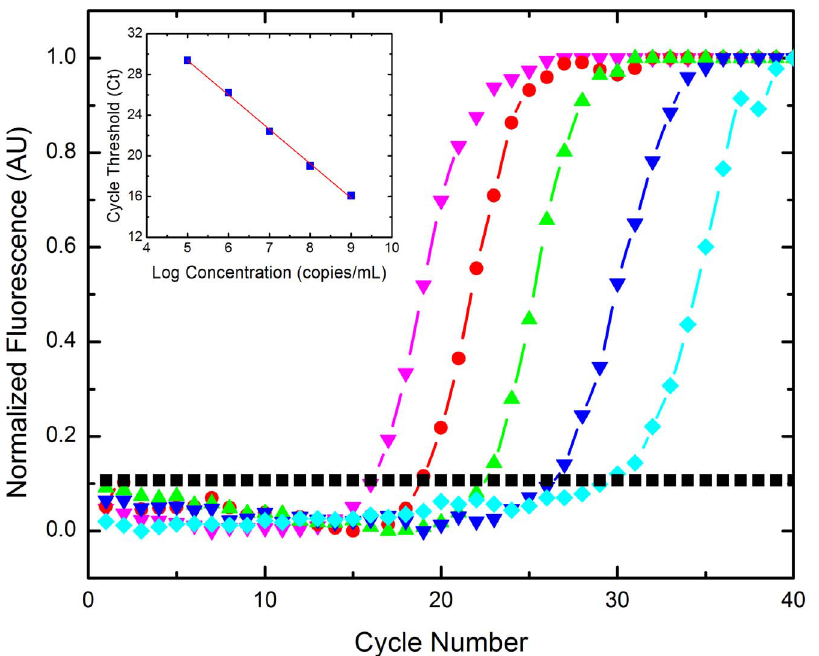
Figure 2. Serial dilution of H3 vRNA of 10 9 2 10 5 copies/mL. Threshold was calculated as 10 6 standard deviation of the background signal. 10 5 N copies/mL was the lowest concentration amplified using the one-step RT-PCR reaction on the tablet platform. Legend: 10 9 copies/mL (pink . ), 10 8 copies/mL (red ), 10 7 copies/mL (green m ), 10 6 copies/mL (blue . ), 10 5 copies/mL (turquoise ¤ ), threshold (black & ). Inset: Efficiency plot of H3 vRNA serial dilution series. Displays the Ct values vs. log concentration of vRNA, with a linear regression fit of R 2 =0.998. The slope of the line is 2 3.38, providing an efficiency of 97.6% using E=10 ( 2 1/slope) 2 1 with an average standard deviation of 6 1.3 cycles.